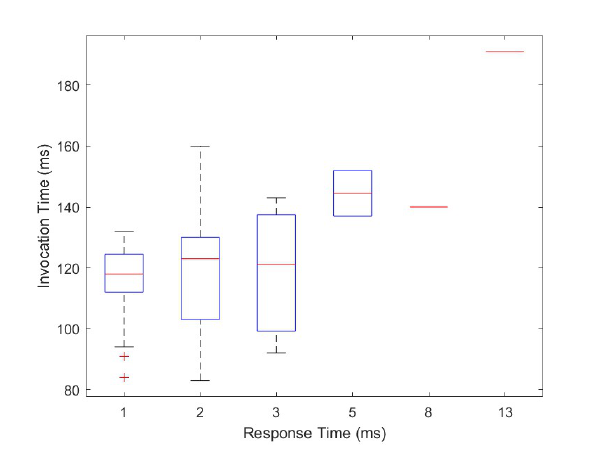
Figure 9. Summary of relation of invocation and response times.